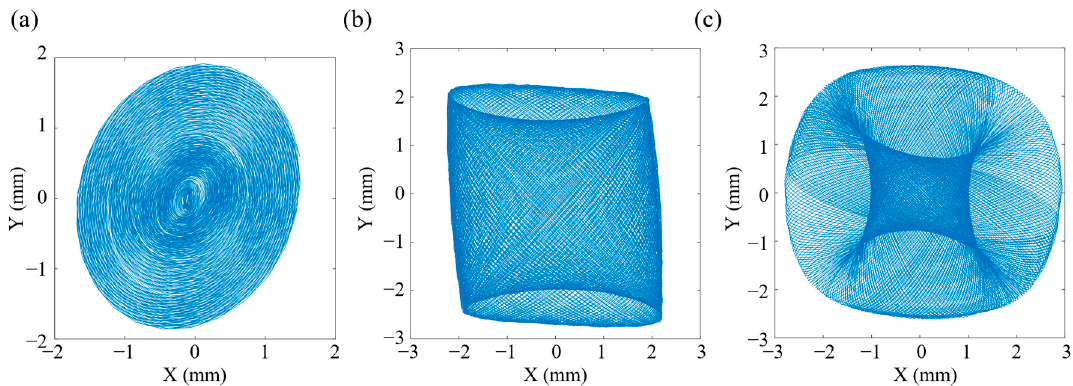
Figure 12. Measurement results of different scanning patterns by PSD. ( a ) Spiral scanning, ( b ) Lis- sajous scanning and ( c ) propeller scanning.